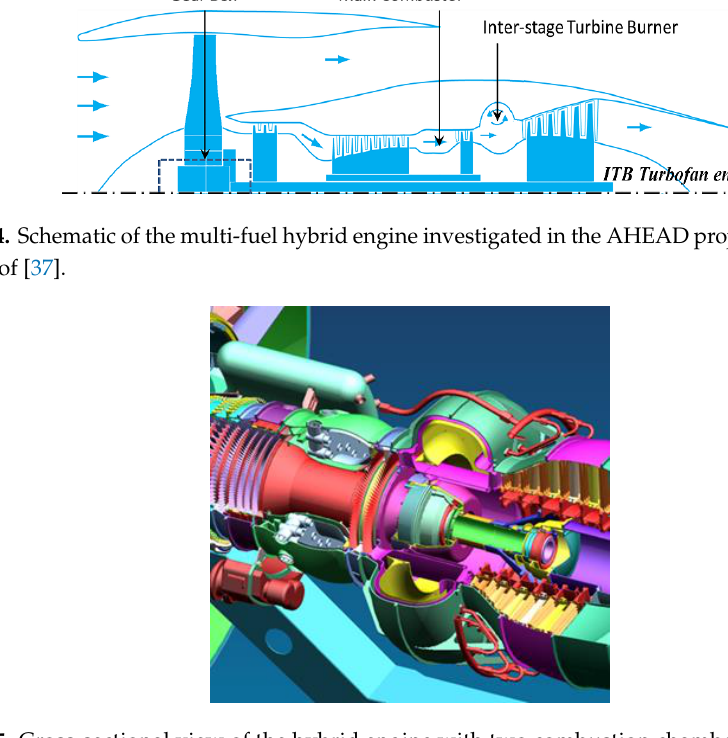
Figure 23. The multi-fuel blended-wing body investigated in the AHEAD project [37].